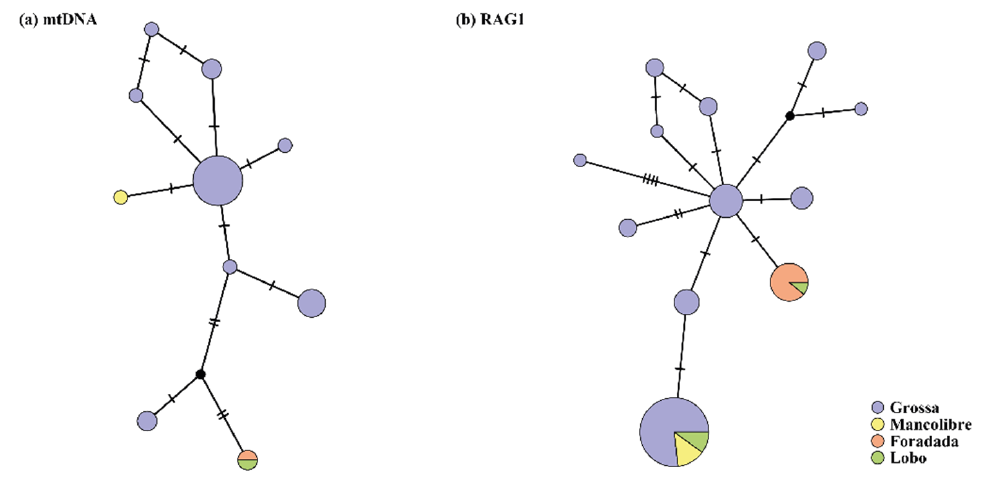
Figure 2. TCS haplotype networks of Columbretes Islands samples for mtDNA alignment ( a ) and for nuclear loci RAG1 ( b ). Black nodes are the inferred intermediate haplotypes.